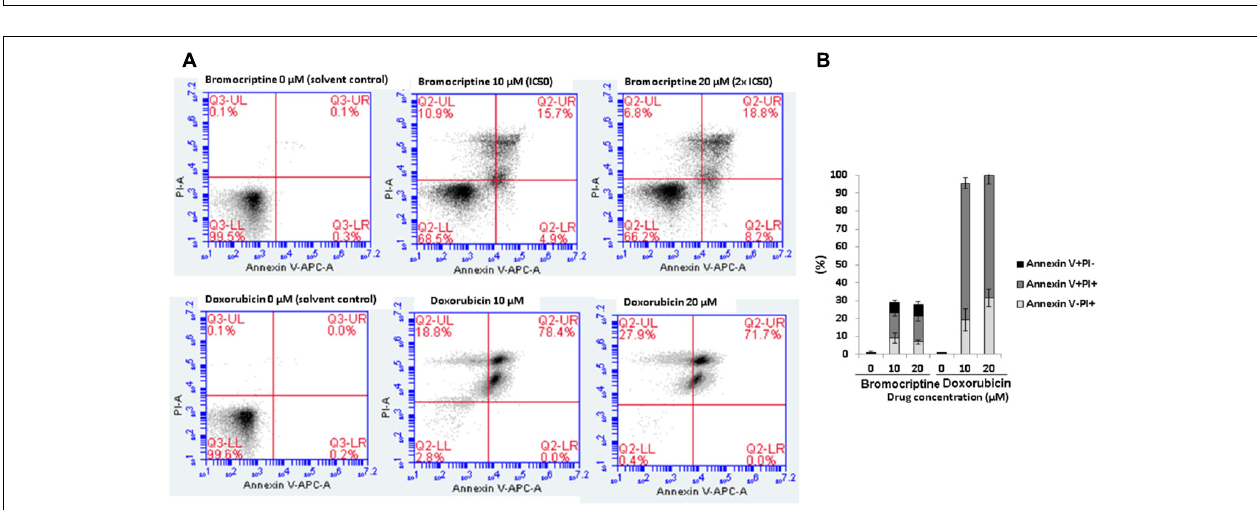
FIGURE 4 | Analysis of cell death in CCRF-CEM cells induced by bromocriptine or doxorubicin. (A) Representative dot plots of flow cytometry analysis after treatment of CCRF-CEM cells with IC 50 or 2 × IC 50 of bromocriptine as well as 10 or 20 µ M doxorubicin for 72 h. (B) The graph shows mean values ± SD of three independent experiments. Annexin V–/PI+: late necrosis, annexin V+/PI+: late apoptosis or early necrosis, and annexin V+/PI–: early apoptosis.